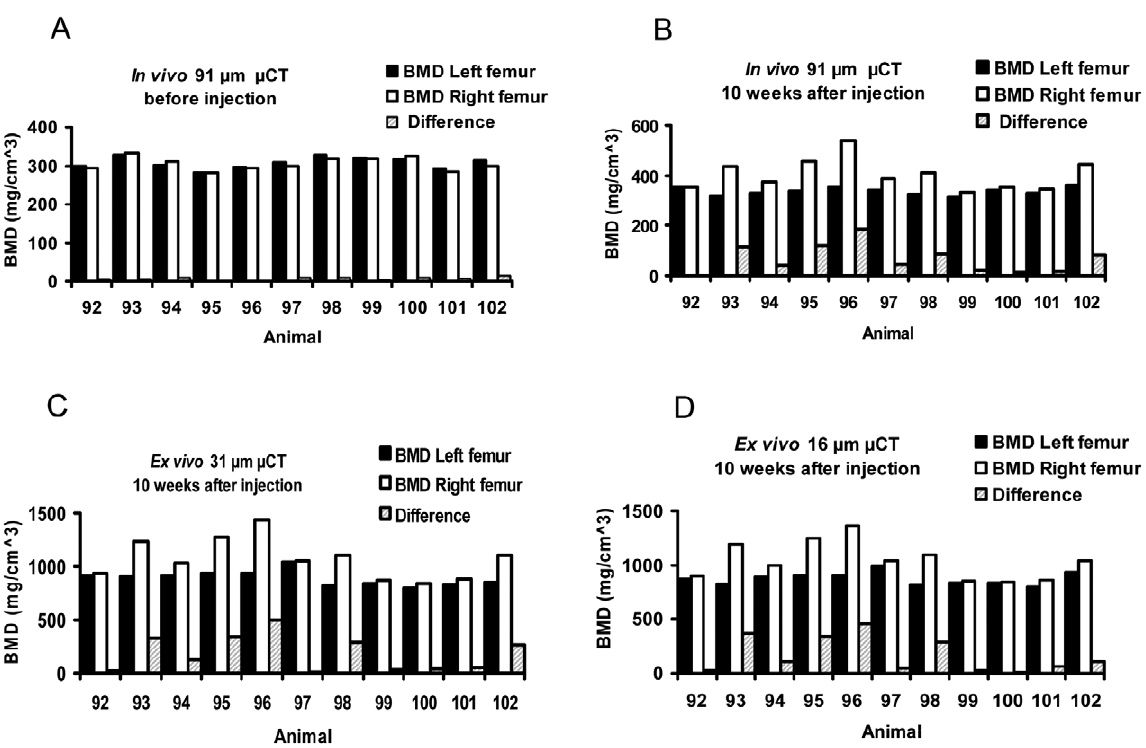
Figure 2. Bone mineral density (BMD) of the diaphysis was greater in the femora involved by prostate cancer. Diaphyseal BMD was measured in both femora by in vivo m CT before injection (A) and 10 weeks after injection (B) of vehicle (left femora) or prostate cancer cells (right femora), and then by ex vivo specimen m CT at 31 m m (C) and 16 m m (D) voxel sizes.